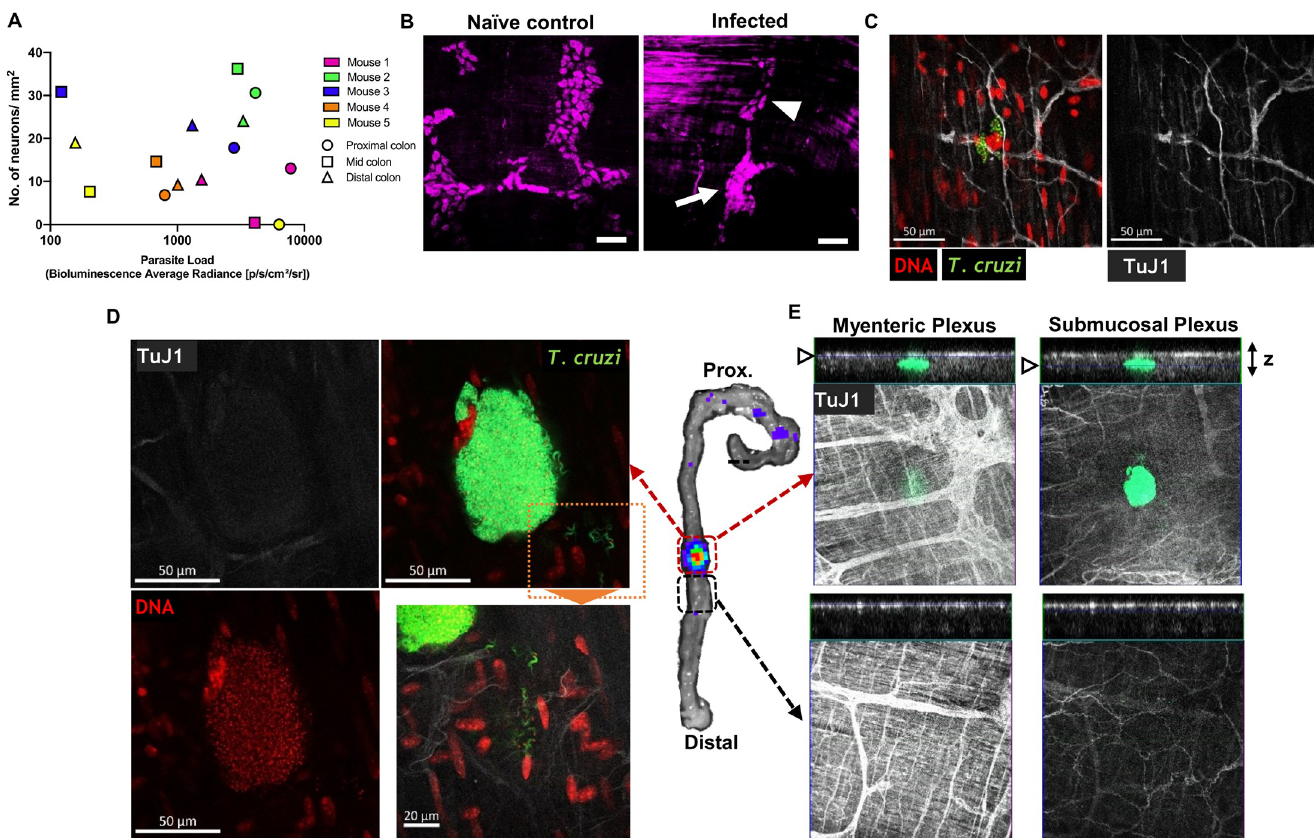
Fig 6. Chronic phase colonic T . cruzi infection foci and ENS ablation at the tissue micro-domain scale. A. Lack of correlation between end-point colon parasite loads measured by ex vivo bioluminescence intensity and degree of colon myenteric plexus denervation. B–E. Whole mount immunofluorescence analysis of colonic muscularis from C3H mice chronically infected with T . cruzi . B. HuC/D + neuronal cell bodies in colonic myenteric ganglia. Na ï ve control shows normal morphology; infected mice exhibit adjacent ganglia with both intact (arrowhead) and disrupted (arrow) staining patterns. C. Imaging individual T . cruzi (mNeonGreen + ) infected cells at early stage of parasite replication cycle adjacent to intact enteric neuron fibres (TuJ1 + ). D–E. Bioluminescence ex vivo image (centre)-guided analysis of parasitized and parasite-free tissue micro-domains. D. Mature parasite pseudocyst containing > 1000 flagellated trypomastigotes with extracellular trypomastigotes in the local tissue parenchyma (inset) with faint neuronal (TuJ1) staining. E. Z-stack slices at the level of myenteric and submucosal neuronal plexuses showing highly localised loss of TuJ1 staining around the rupturing parasite pseudocyst.